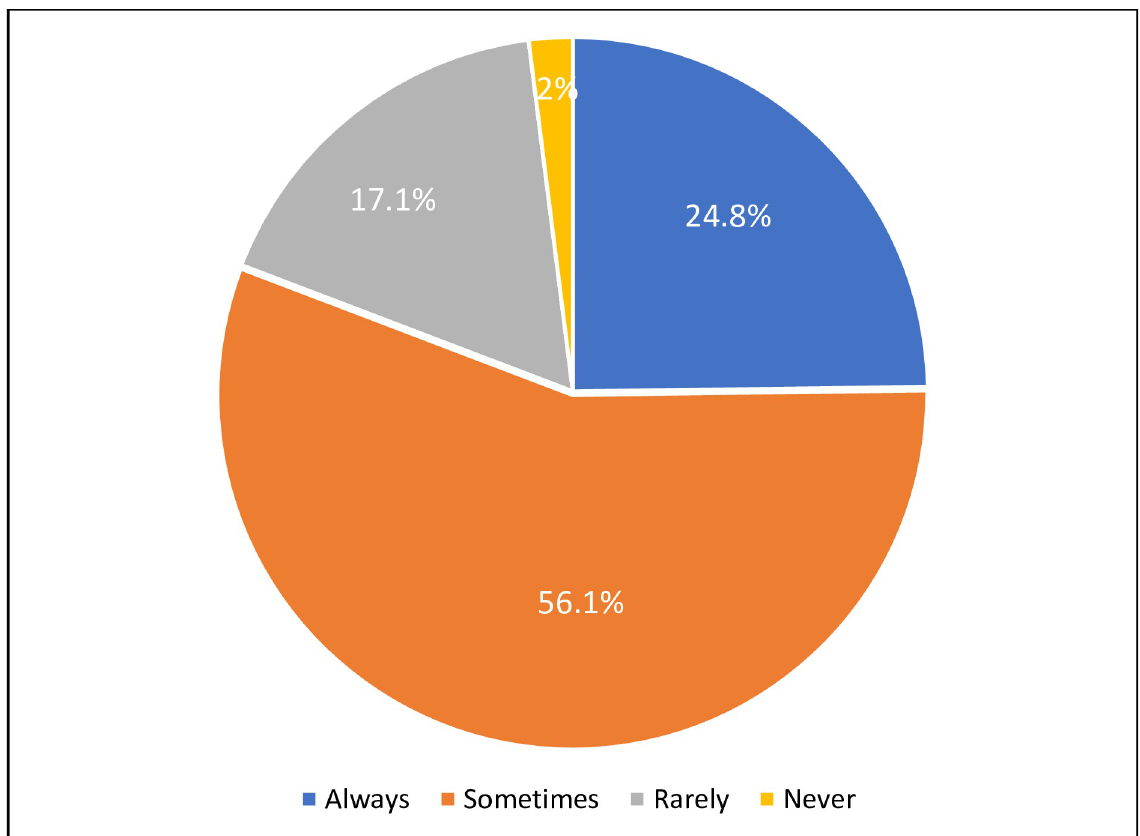
Fig 5. Percentage of respondents who reported reading food labels to check for information on food additives (n = 1038).